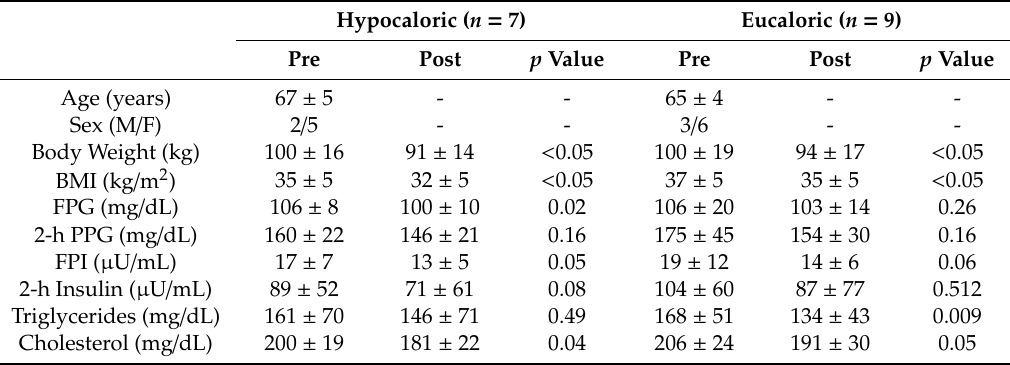
Table 1. Participant characteristics before and after lifestyle